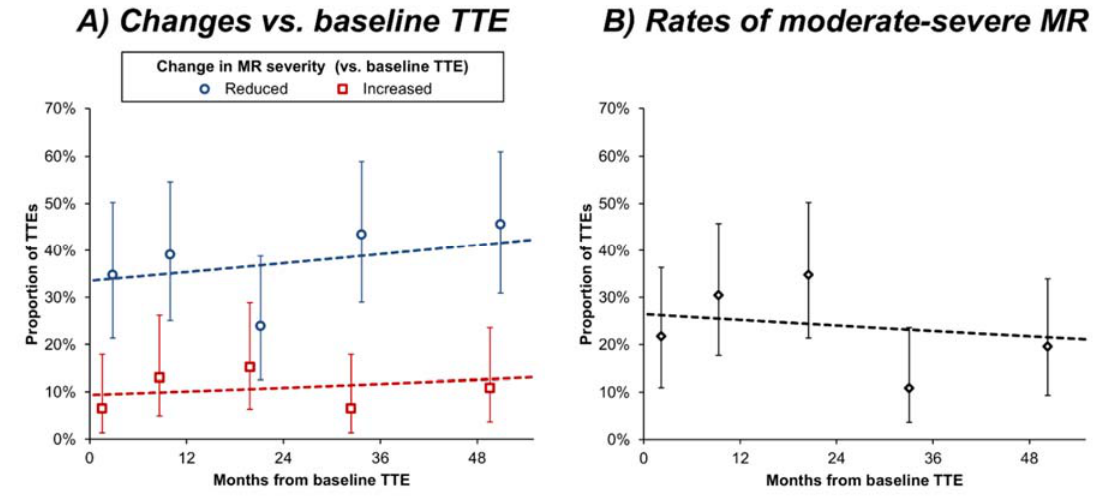
Figure 2. Changes in MR severity over time. Analyses are based on the n = 230 follow ‐ up TTEs. Trends over time in MR were assessed using three generalized estimating equation models, each of which had a single covariate, indicating the timing of the TTE, relative to the baseline TTE. ( A ) visualises two of these models, with dependent variables specifying whether each TTE indicated an increase in MR severity, or a reduction in MR severity, respectively, compared to the baseline TTE. For ( B ) the dependent variable specified whether each TTE indicated moderate ‐ to ‐ severe MR. The resulting models are represented by broken lines. Points represent the observed rates of each outcome within subgroups of n = 46 consecutive TTEs (i.e., quintiles), and are plotted at the mean of the interval; whiskers represent 95% confidence intervals. MR = mitral regurgitation; TTE = transthoracic echocardiography.